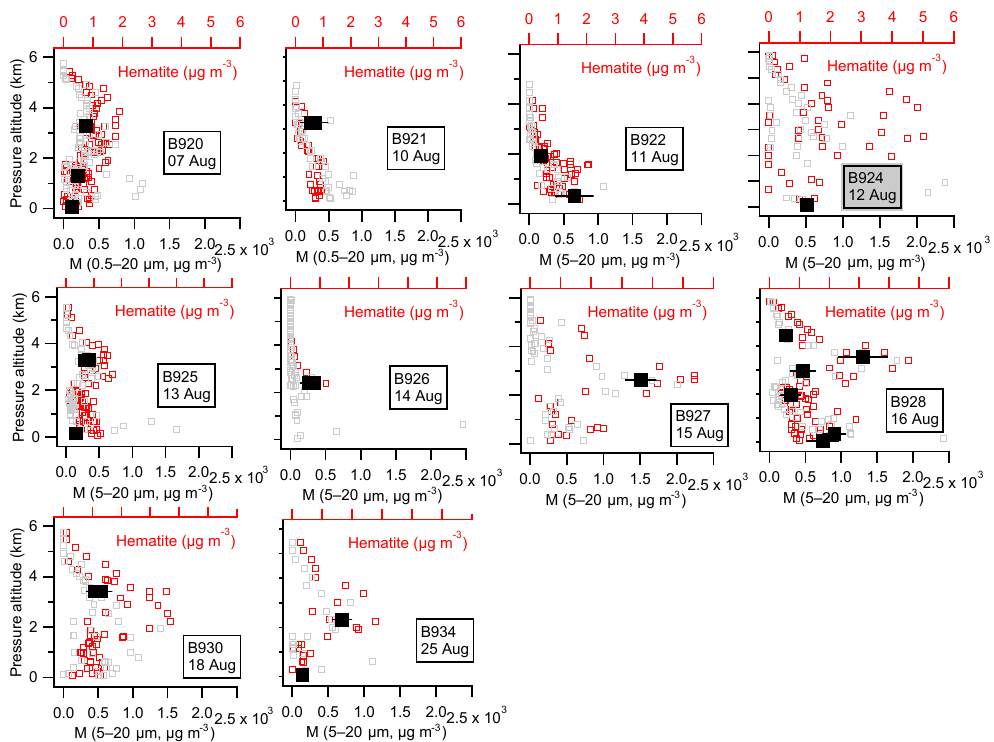
Figure 5. The aerosol mass concentration ( d = 0.5–20µm) derived from PCASP and CDP size distributions and hematite loading from the SP2 in the profiles. The black markers show the mean aerosol mass ( d = 0.5–20µm) derived during SLRs with error bars showing ± 1 standard deviation. The high-level remote sensing flight (B923), the flight without the AMS running (B929) and the flights without aerosol profiles or SLRs (B931 and B933), or the flight without successful AMS measurements (B932), are excluded from the analysis here.